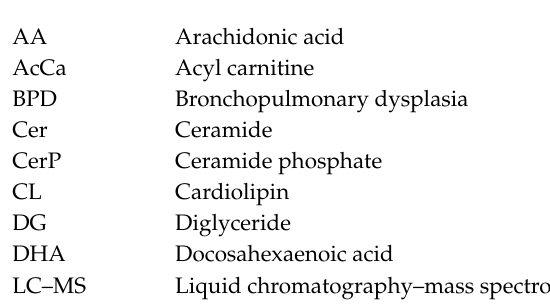
Figure S1: Simplified schematic of synthesis and hydrolysis of glycerophospholipid, Figure S2: Lung glycerophospholipid species in mice exposed to hyperoxia as neonates, Figure S3: Compositional changes of lung glycerophospholipid species in mice exposed to hyperoxia as neonates, Figure S4: Sphingolipid metabolic pathway, Figure S5: Lung sphingolipid species in mice exposed to hyperoxia as neonates, Figure S6: Compositional changes of lung TG and DG species in mice exposed to hyperoxia as neonates, Table S1: All lung lipid species in mice exposed to hyperoxia as